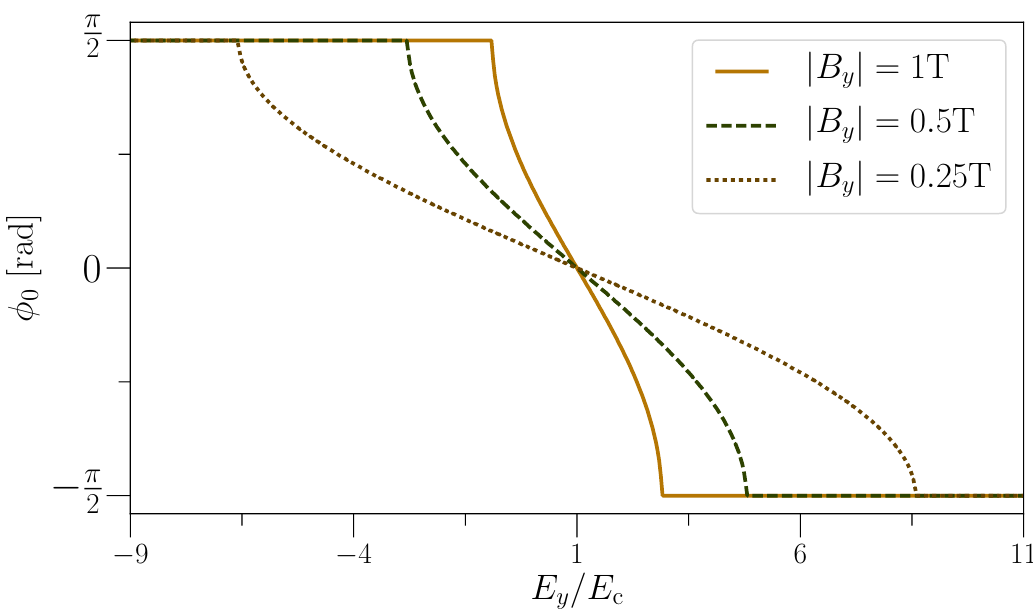
/ E , for three y c | = 0.5T y